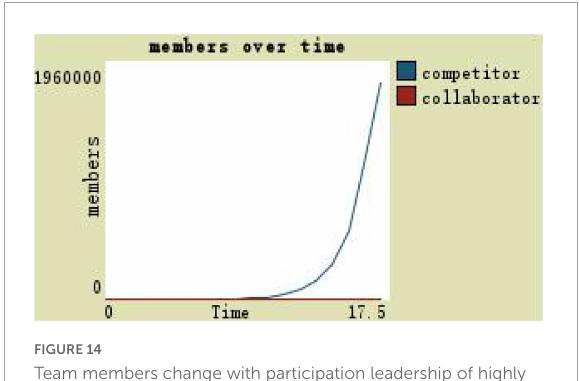
FIGURE14 Team members change with participation leadership of highly motivated and low-trust